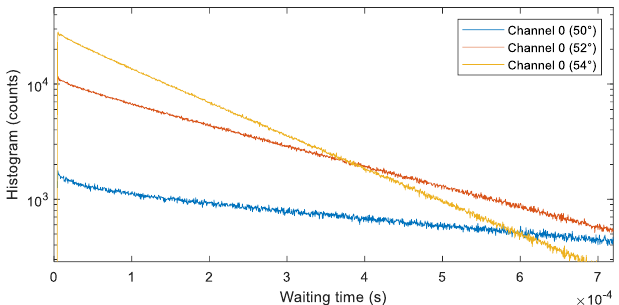
Fig. 6. Histograms of waiting times for 3 angles of the shutter (channel 0, inner